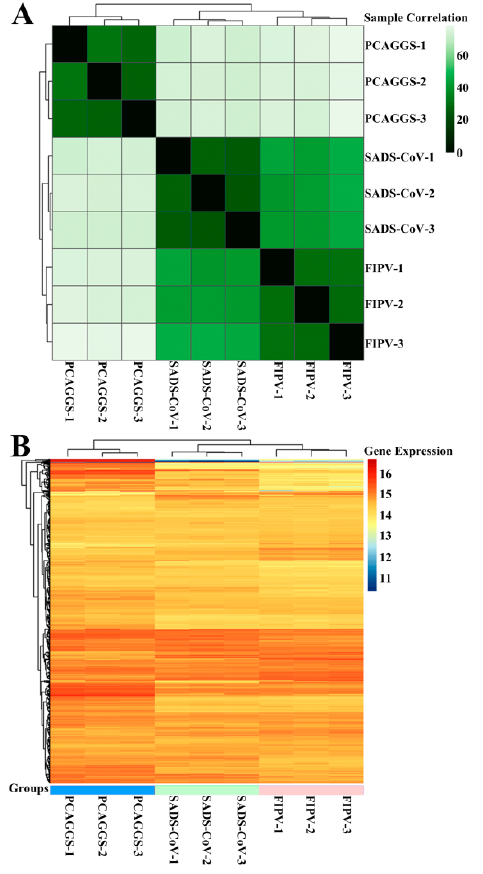
Figure 4. RNA sequences in HEK-293T cells transfected with SADS-CoV nsp1 or FIPV nsp1. ( A ) The correlations between samples are shown. Horizontal and vertical axes represent each sample, and di ff erent colors represent di ff erent correlation coe ffi cients. ( B ) The abscissa represents the sample name and the clustering results for the sample, and the ordinate represents the di ff erentially expressed genes and the clustering results for the genes. Di ff erent columns represent di ff erent samples, and di ff erent rows represent di ff erent genes. Colors represent the log2 (normalized counts) values of the expression levels for the genes in the samples.